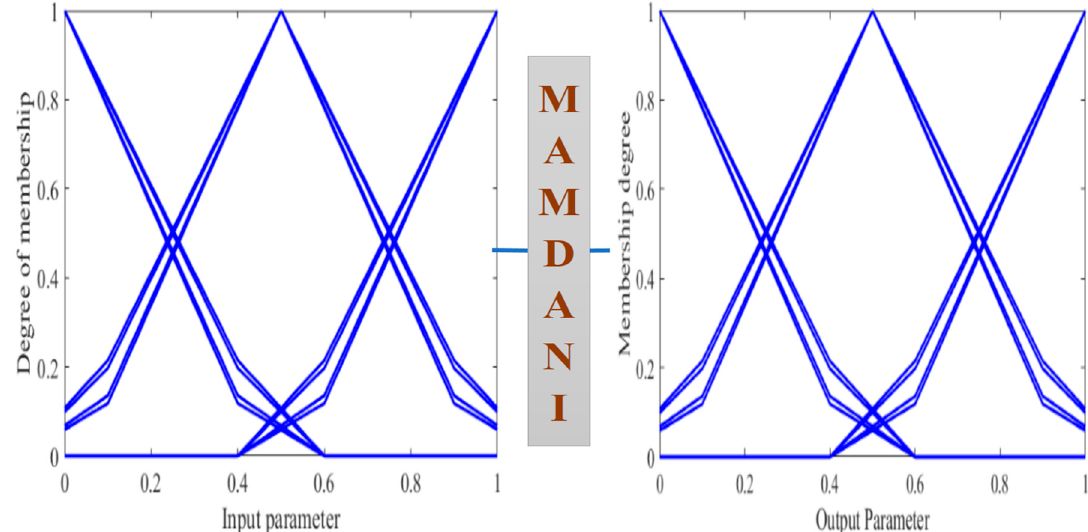
Figure 6. Structure of the Shadowed Type-2 fuzzy system.